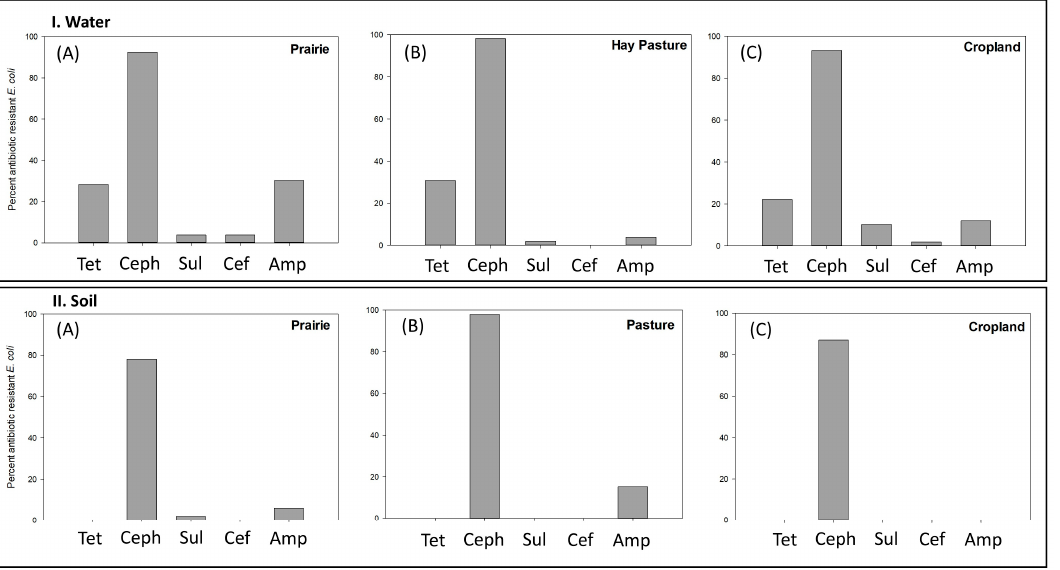
Figure 3. Percentage of antimicrobial resistance (AMR) in ( I ) water and ( II ) Soil within E. coli isolates in the three sites (A) Prairie, (B) Pasture and (C) Cropland. Tet—Tetracycline, Ceph—Cephalothin,